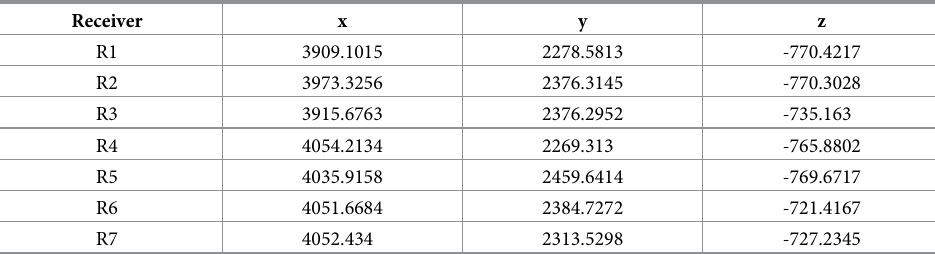
Table 4. Coordinates of the accelerators installed in Dongguashan Copper